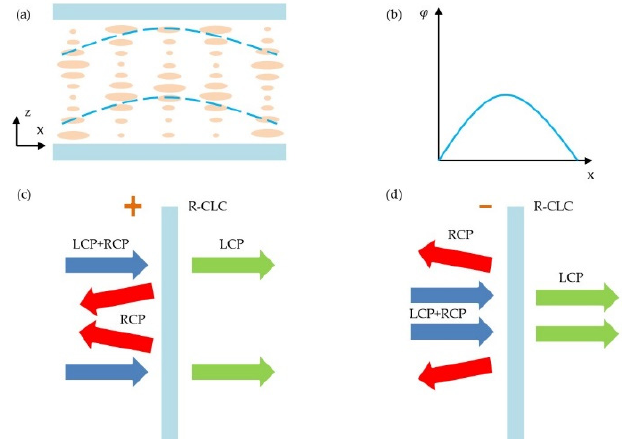
Figure 14. ( a ) The polarization volume lense (PVL) twisting structure of the side view. ( b ) The corresponding phase profile. Lensing behaviors of a cholesteric LC (CLC) lens with ( c ) positive power and ( d ) negative power.